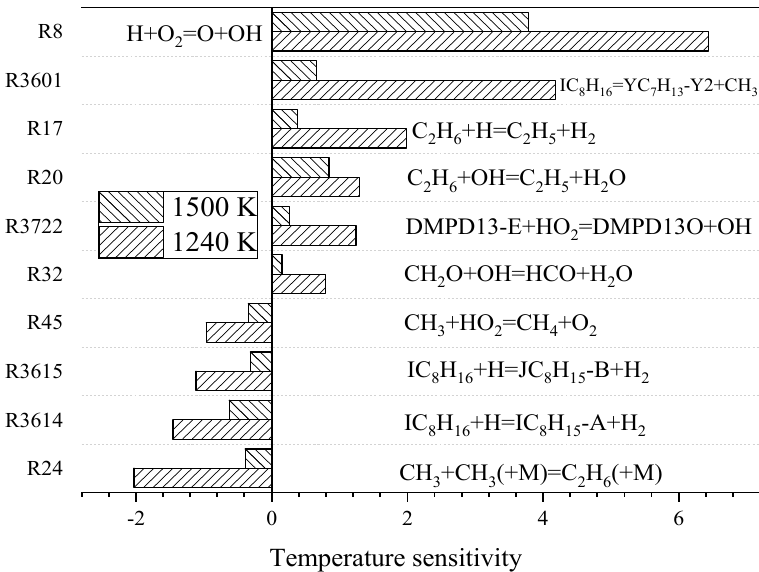
Figure 6. Temperature sensitivity coefficient simulated by shock tube model for IC 8 H 16 . Pressure 4.0 atm and 1240 and 1500 K.